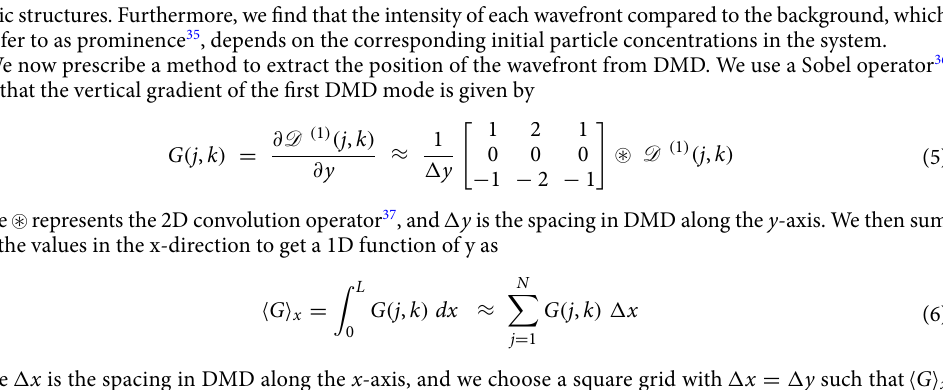
Fig. 4b. Using a non-linear least squares fit method we find that the relation is of the form Y WF ∼ a St 2 + b St + c , with values of the parameters a , b , and c as indicated in Fig. 4b, where x represents St . Now, extrapolating the fit we find that Y WF = 0 at St = 0.3767 and becomes multi-valued for St > 3.0979 , thus setting the limits on the validity of the relation. In stagnation-point flows below a certain value of Stokes number normally there are no caustics, as shown by Healy et al. 22 ; the lower cut-off for the Stokes number in our case could be indicative of a similar phenomenon. The fact that St = 0.37 appears as a hard cut-off for caustics could be circumstantial and tied to the choice of initial condition and flows can actually display caustics at any Stokes number. Furthermore,